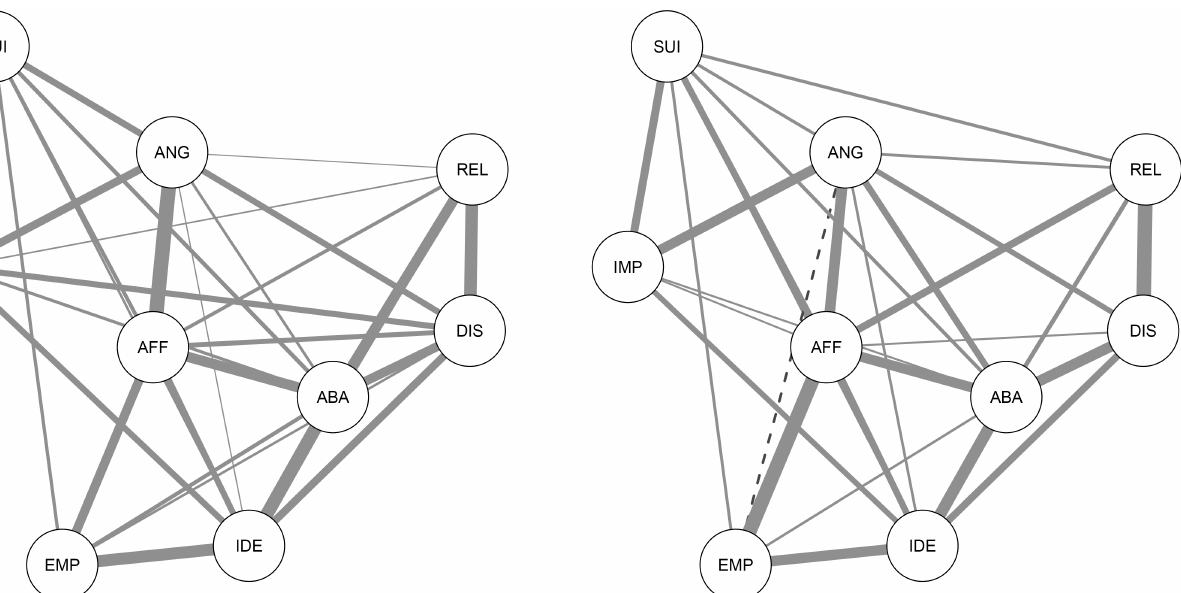
PLOS ONE | https://doi.org/10.1371/journal.pone.0186695 October 17,